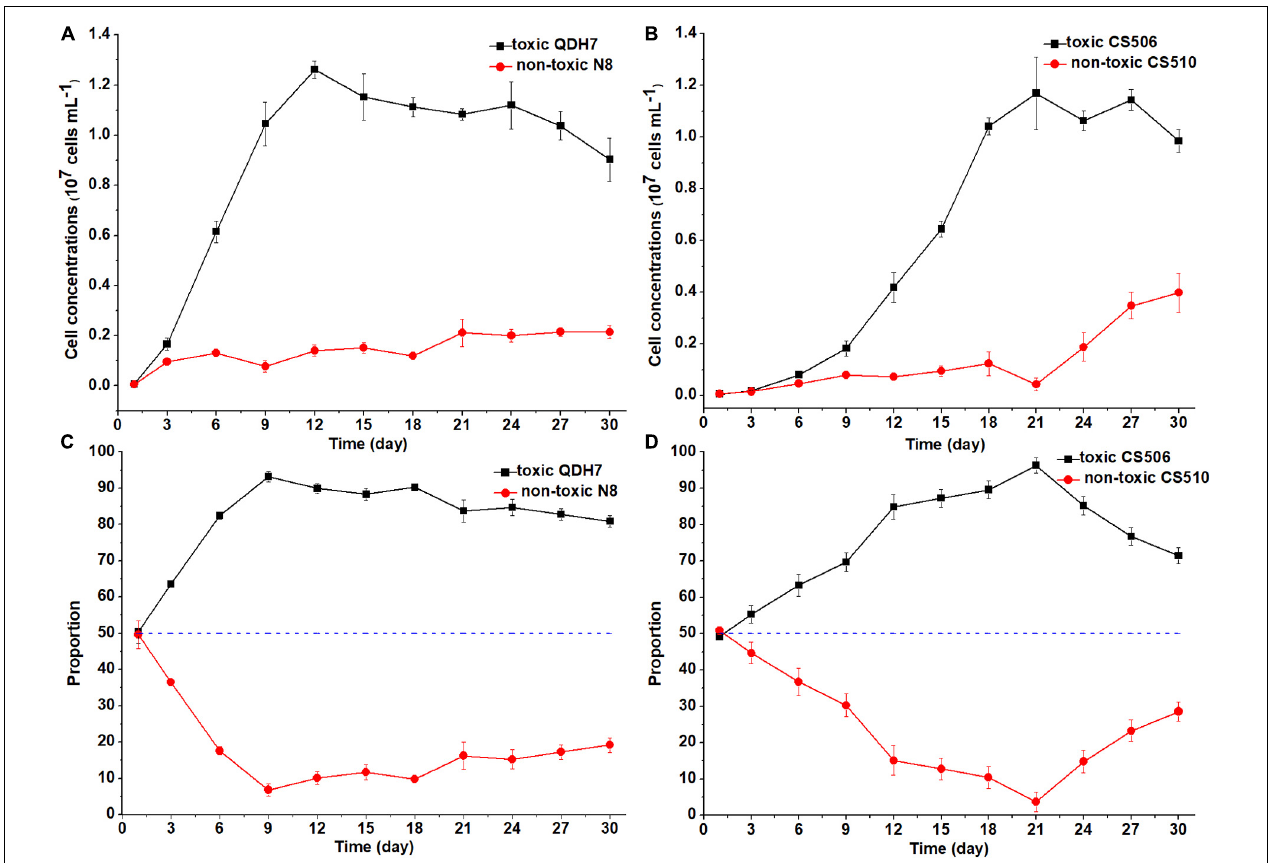
FIGURE 5 | Changes in cell concentrations of toxic ( cyrJ copy numbers) and non-toxic (the differences between rpoC1 and cyrJ copy numbers) R. raciborskii , and proportion of toxic and non-toxic strains under BG11 control condition. Panels (A,C) showed data for QDH7/N8 co-culture experiments, whereas panels (B,D) showed data for CS506/CS510 co-culture experiments. These experiments were started with equal amounts of CYN-producing and non-CYN-producing cells (1:1, blue dotted line in panels (C,D)